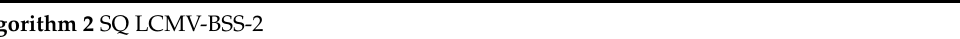
Algorithm 2 SQ LCMV-BSS-2